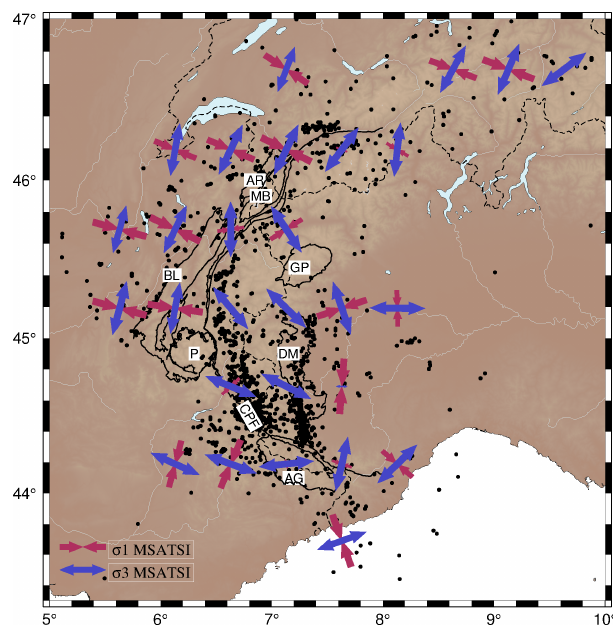
Figure 6. Stress orientations resulting from MSATSI inversion (based on the SI method) on a 0.5 ◦ × 0.5 ◦ grid, for all cells contain- ing at least 10 focal mechanisms (black dots). The most compres- sional ( σ 1, in red) and least compressional ( σ 3, in blue) stresses are projected according to their plunge. Solid lines and their labels refer to major geological features described in Fig.